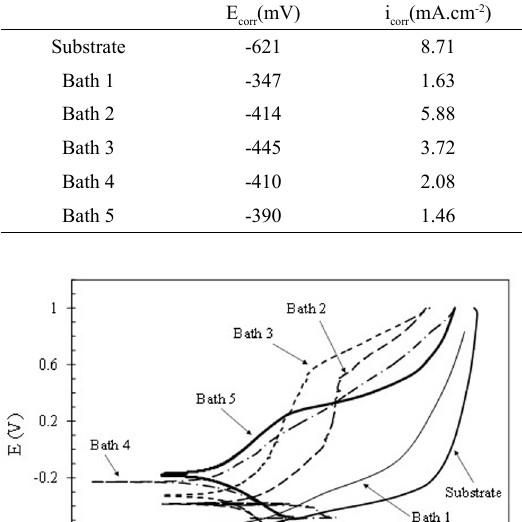
Figure 11. Potentiodynamic polarization curves of the as-deposited coatings obtained in baths with different tungsten concentrations. ) and corrosion current densities Table 7. Corrosion potentials (E corr (i ) obtained from the polarization curves shown in Fig. 11. corr